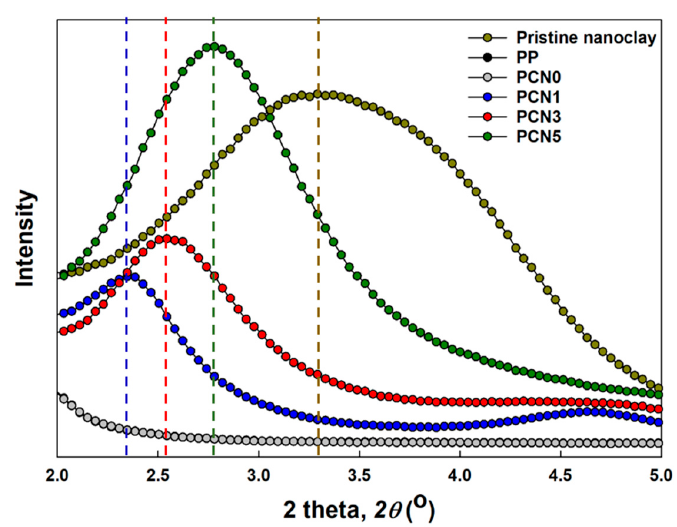
Figure 6. XRD spectra of pristine nanoclay, PP, PP / CNF, and PP / CNF / nanoclay nanocomposites in low 2 θ range.